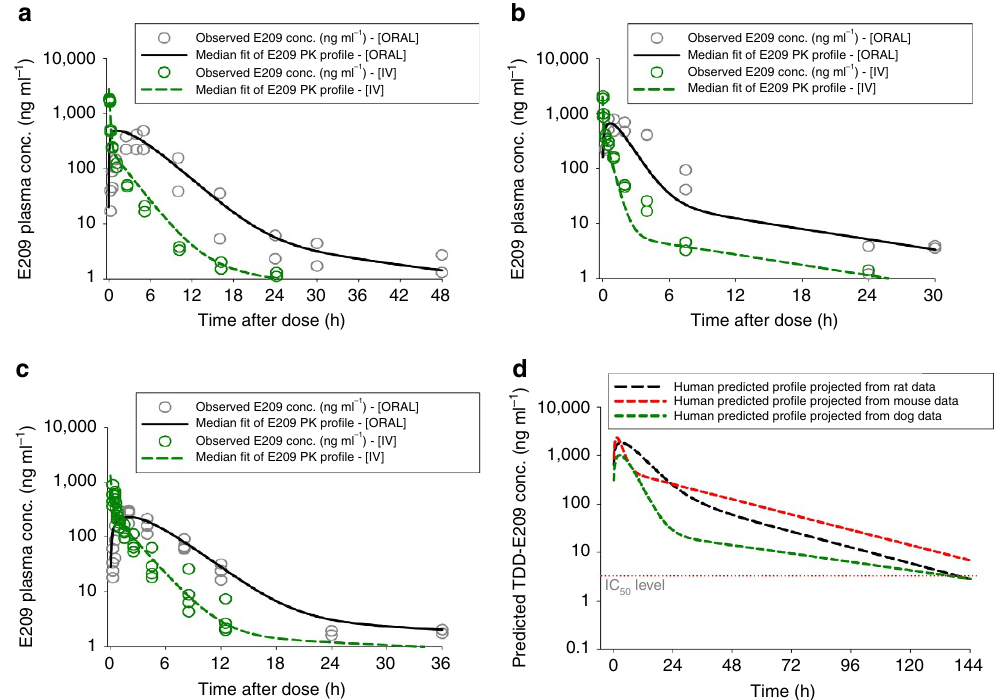
Figure 5 | Measured rodent and predicted human exposure profiles. PK profiles of E209 in male Sprague–Dawley rats ( a oral dose ¼ 9mgkg (cid:3) 1 , IV dose ¼ 2mgkg (cid:3) 1 ), outbred female Swiss mice ( b oral dose ¼ 10mgkg (cid:3) 1 , IV dose ¼ 2mgkg (cid:3) 1 ) and the male beagle dog ( c oral dose ¼ 5mgkg (cid:3) 1 , IV dose ¼ 1mgkg (cid:3) 1 ) and allometrically scaled predictions for human PK ( d ) based on all of the above assuming an oral dose of 15mgkg (cid:3) 1 . Fits constructed are based on predicted median PK parameter